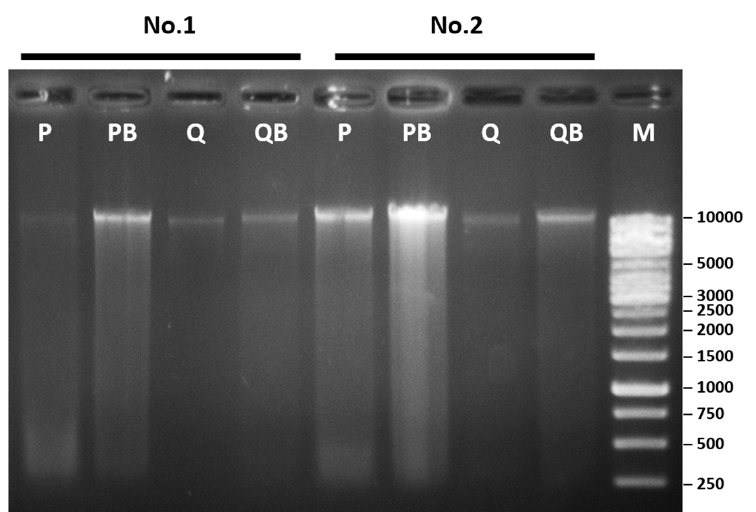
Figure 5. Evaluation of DNA integrity via the gel-electrophoresis of DNA extracted using the phenol-chloroform extraction method (P), the phenol-chloroform extraction method with glass beads (PB), the QIAamp Fast DNA Stool Mini Kit (Q), and the QIAamp Power Fecal Pro DNA Kit (QB).